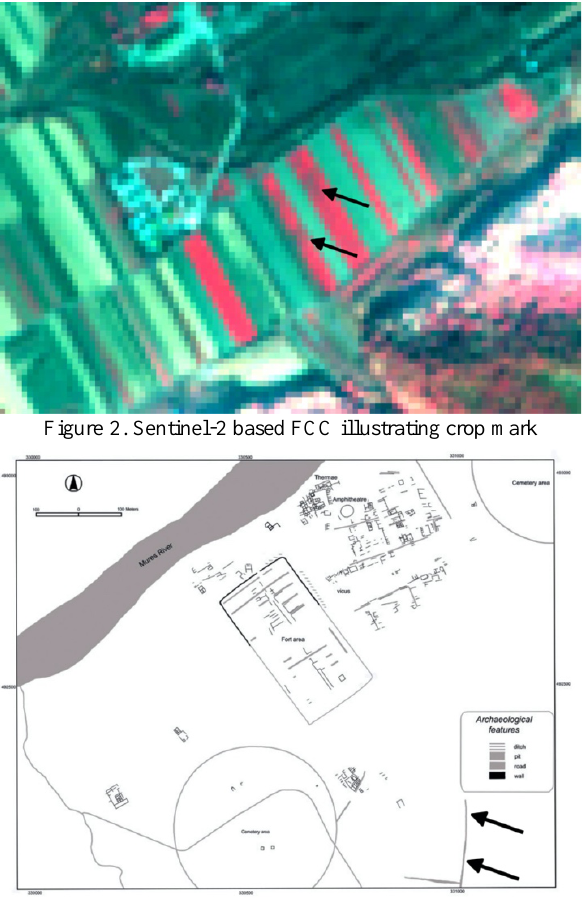
Figure 3. Map of the Micia Roman Fort (Oltean, 2007)